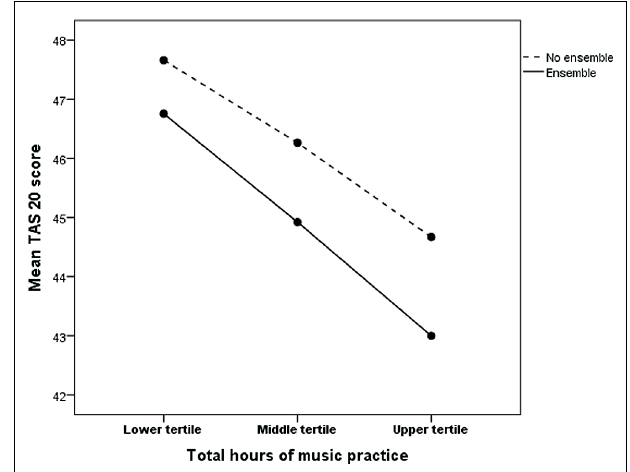
FIGURE 1 |Age adjusted marginalTorontoAlexithymia Scale (TAS-20) means for ensemble (yes/no) and music practice tertiles among subjects (men) who have practiced playing an instrument. Music practice tertiles: lower, range 40–800, median 360, Middle, range 840–3160, median 1600, Upper, range 3200–18400, median 5600.